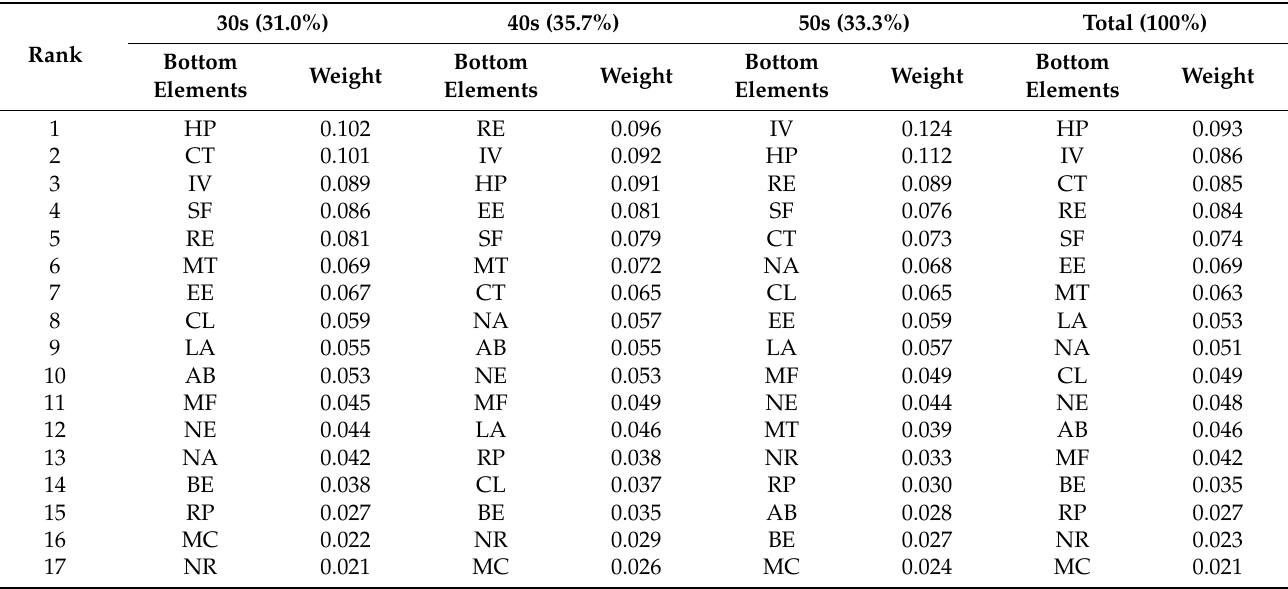
Table 8. The AHP Analysis of Age Group